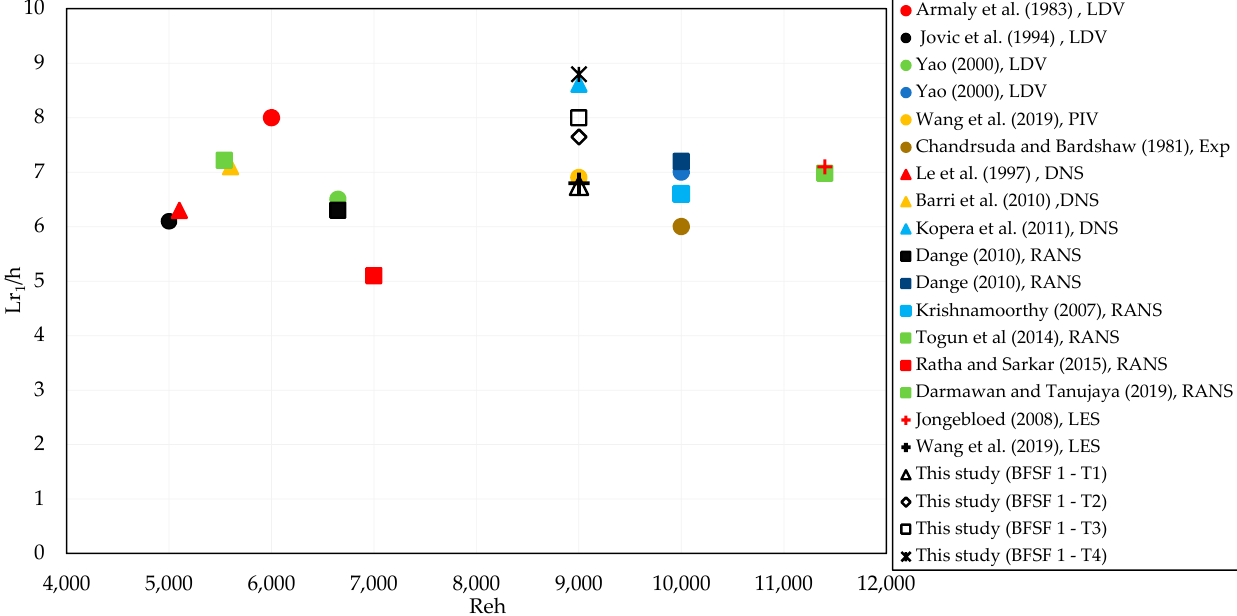
Figure 9. Dimensionless primary reattachment length (Lr 1 /h) vs. Re h in turbulent flow [1,3,30,54–64]. In the turbulent flow over the backward-facing step, the reattachment length is in- dependent of the step-height Reynolds number- and is mostly between 5 and 8 times the step height. This is consistent with the present study. The present numerical results were compared with experimental data and numerical results [1] at Re h = 9000 and ER = 2. Table 9 lists the value of the reattachment lengths in the BFSF. Table 9. Reattachment length in past numerical and experimental